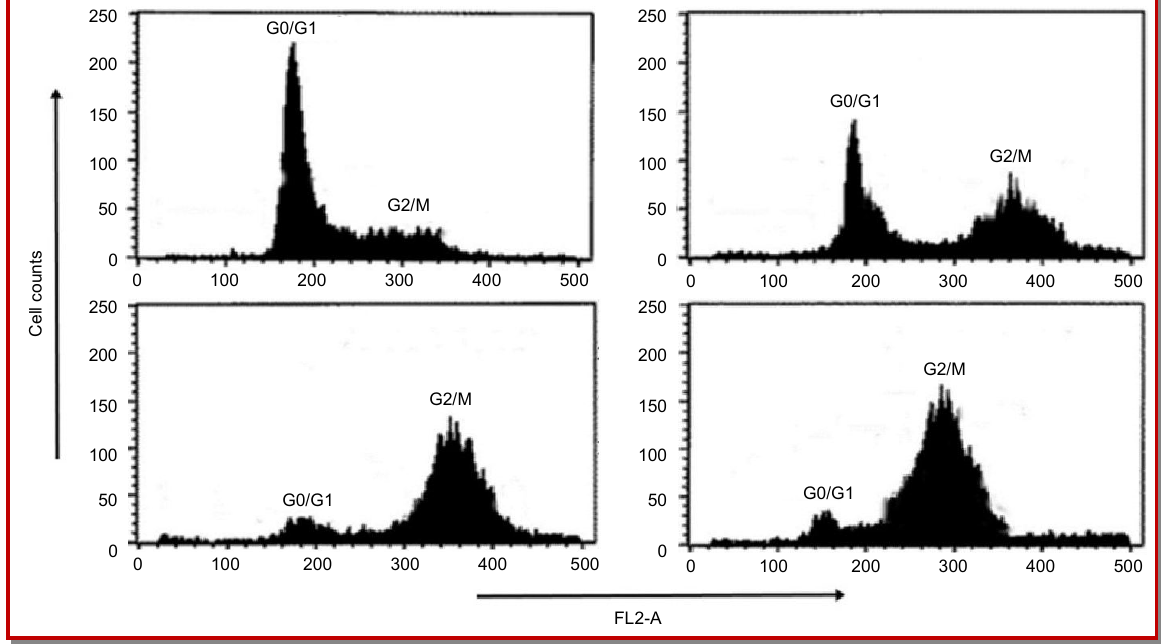
Figure 4: Effect of alloimperatorin epoxide on cell cycle progression in HL-60 human leukemia cells. As shown, alloimperatorin induced G2/M phase cell cycle arrest which showed strong dose-dependence. A represents untreated control, B, C and D repre- sent effect of 4, 32 and 128 µM dose of alloimperatorin epoxide on cell cycle phase distribution. The cell cycle experiment was performed using FACS Calibur flow cytometer. The data presented here are representative of at least three separate experiments